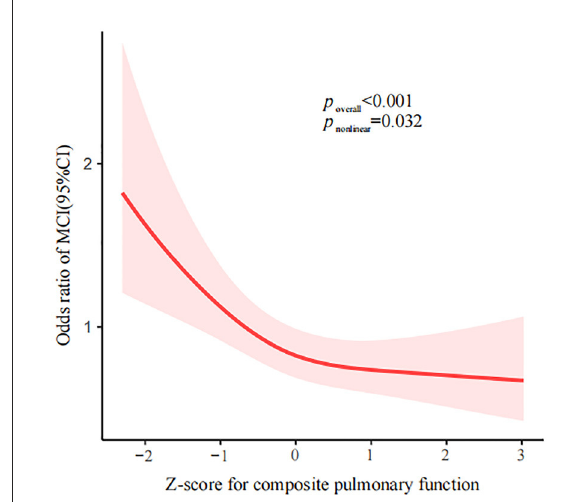
FIGURE2 Association between z -score for composite pulmonary function and MCI using a restricted cubic spline regression. Multivariable adjusted odds ratios (ORs) and 95% CIs were derived from restricted cubic spline regression, with knots placed at the 10th, 50th, and 90th percentiles of z -score for composite pulmonary function. Solid red line represents multivariable adjusted odds ratios, with shaded part showing 95% confidence interval. Model adjusted for the same variables as model 3 in Table 2. MCI, mild cognitive impairment; ORs, odds ratio; CIs, confidence interval.